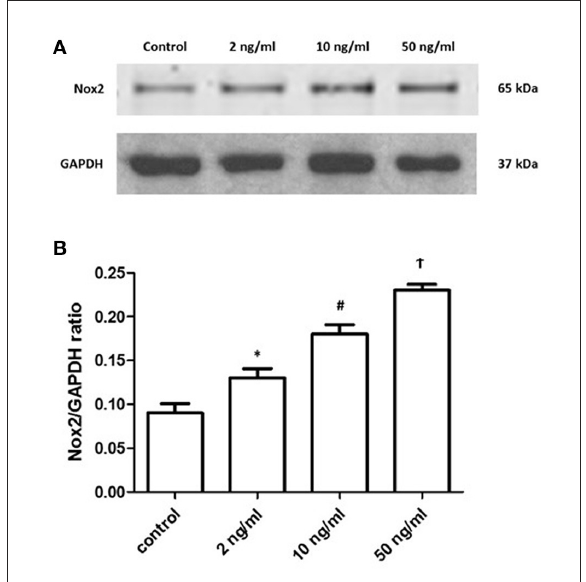
FIGURE4 PDGF-BB stimulation increased the expression of NOX2 under a dose-dependent manner. (A) Representative images of the expression of NOX2 under the stimulation of PDGF-BB were shown. (B) The ratios of NOX2 to GAPDH were shown. The expression of NOX2 showed the dose-dependent manner under the PDGF-BB stimulation ( P < 0.05). N = 4. * P < 0.05 vs. control; # P < 0.05 vs. 2ng/ml group; † P < 0.05 vs. 10ng/ml